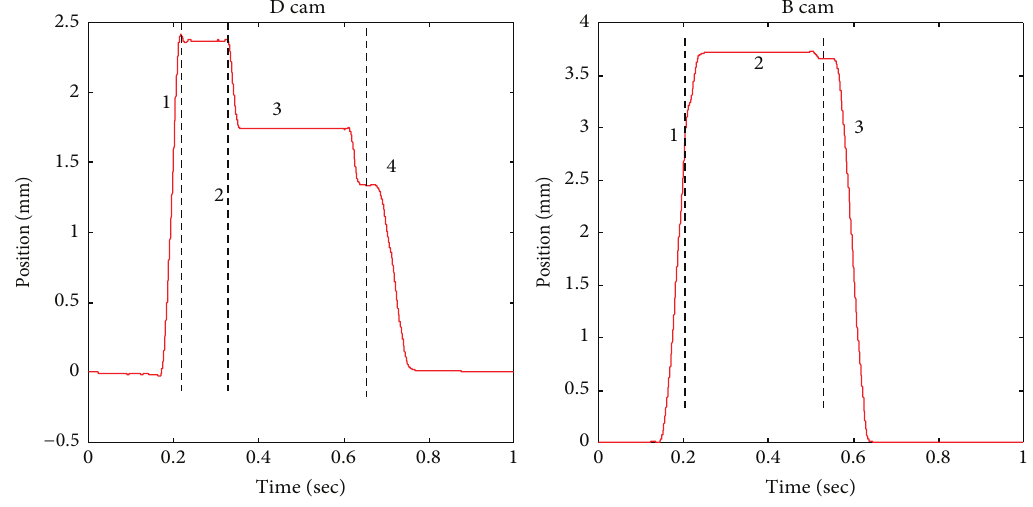
Figure 8: Segmentation of displacement profiles for system